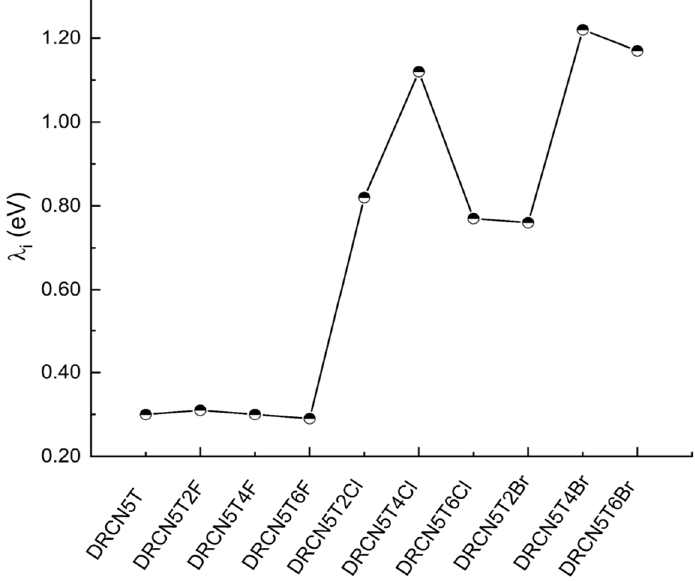
Figure 6. Calculated inner reorganization energies (eV) of DRCN5T, DRCN5T2F, DRCN5T4F, DRCN5T6F, DRCN5T2Cl, DRCN5T4Cl, DRCN5T6Cl, DRCN5T2Br, DRCN5T4Br, and DRCN5T6Br DRCN5T6F, DRCN5T2Cl, DRCN5T4Cl, DRCN5T6Cl, DRCN5T2Br, DRCN5T4Br, and DRCN5T6Br by using CAM-B3LYP/6 − 31+G(d) in by using CAM-B3LYP/6 − 31+G(d) in film.